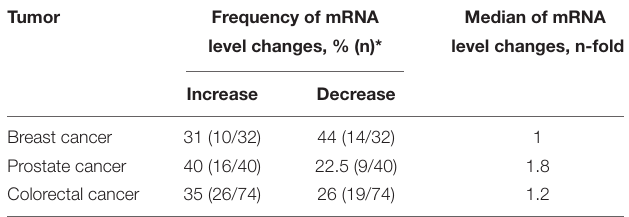
TABLE 1 | Frequency of mRNA level changes in breast, prostate, and colorectal cancer.